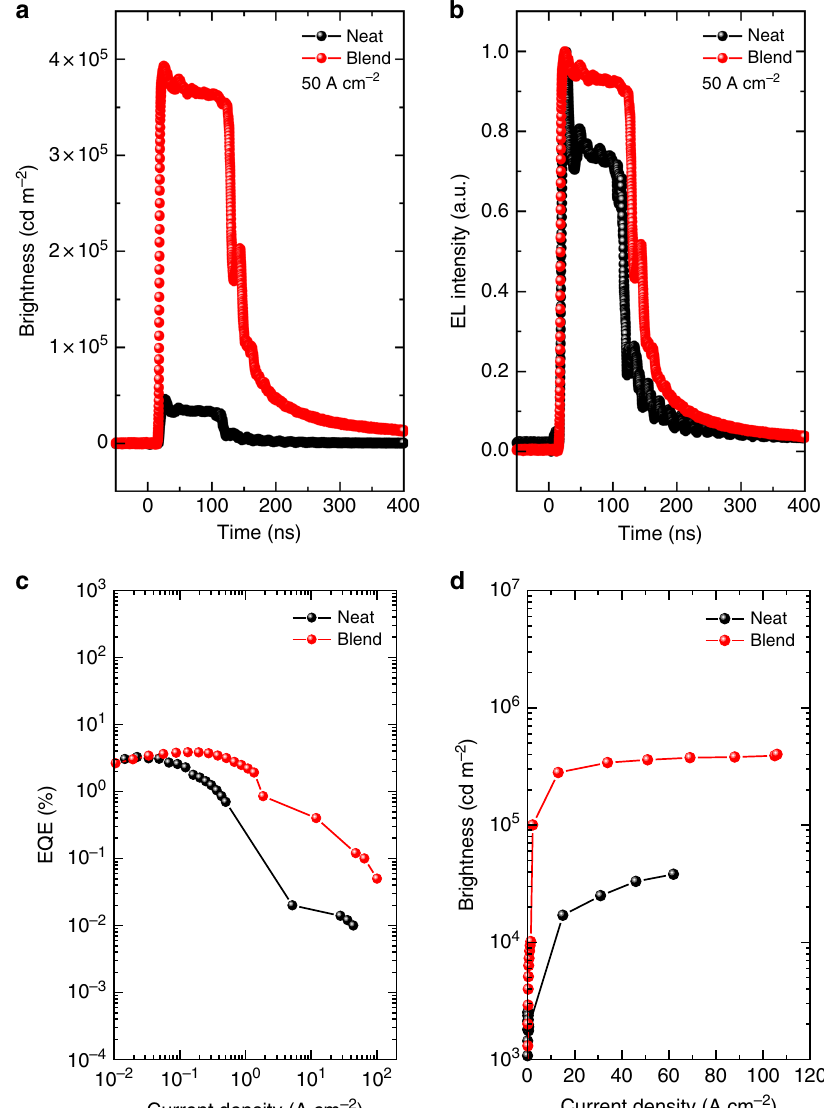
Fig. 6 Brightness and EQE comparison of neat (black) and mCP-COT blend (red) small-area OLEDs for pulse inputs. a A comparison of EL intensity of the neat and blend BSBCz-EH OLEDs at a current density of 50 A cm − 2 . b Normalised EL intensities, showing a signi fi cant STA in the neat device and substantial reduction of the same in blend. c EQE versus current density for neat and blend devices at 50 A cm − 2 . d Brightness versus current density plot for neat and blend devices. OLED area = 0.2 mm 2 ; pulse widths = 100